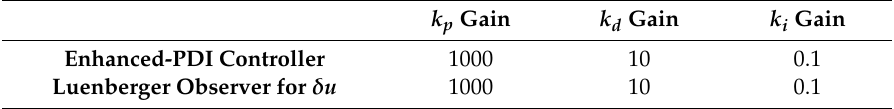
Table 1. Tuned gain values 1 for the PDI controller and observer.